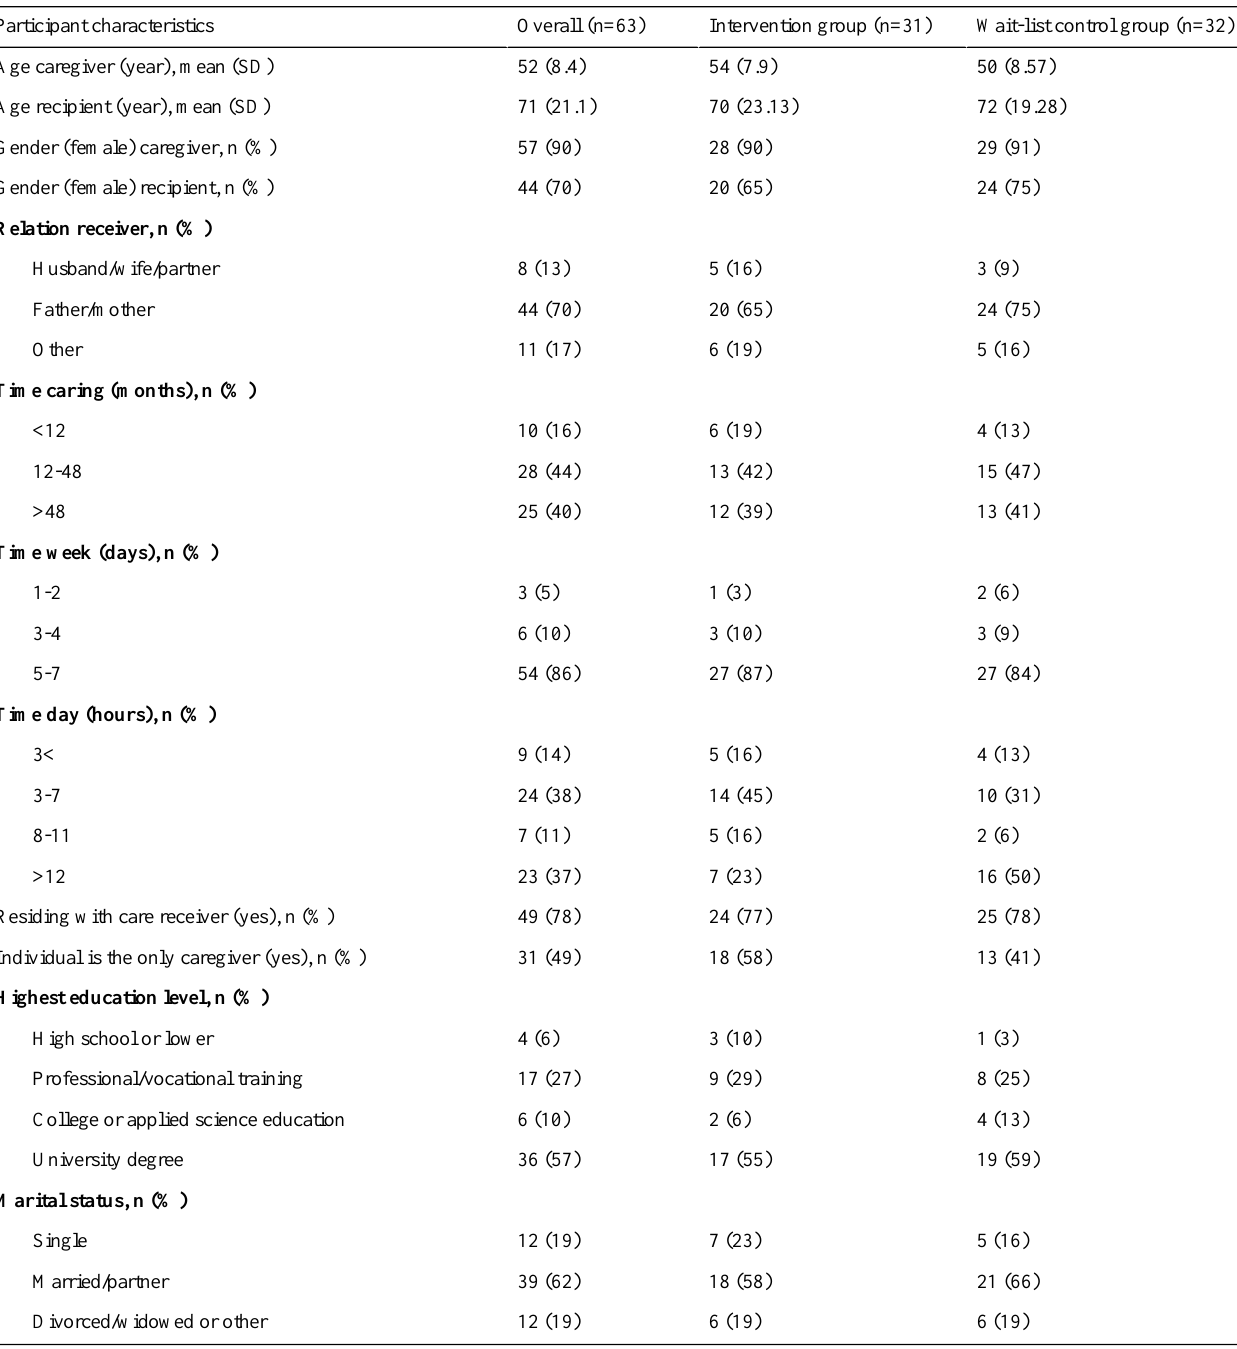
Table 2. Sociodemographic characteristics of the sample at